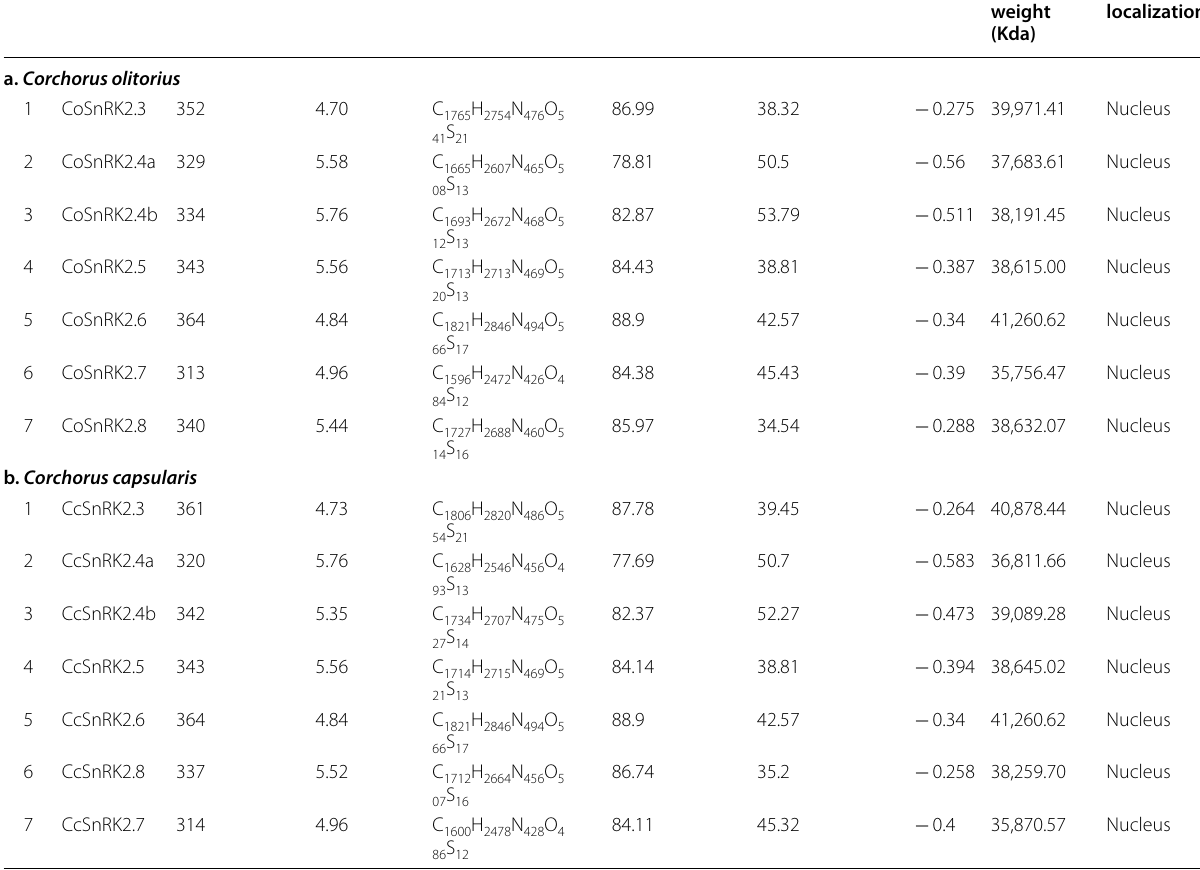
Table 2 Details of SnRK2 genes identified from the genome-wide search analysis. The table shows the following details: putative SnRK2 gene name, protein length (number of amino acids), isoelectric point (pI), molecular formula, Aliphatic index, Instability index, GRAVY, predicted molecular mass, and subcellular localization in Corchorus olitorius (a) and Corchorus capsularis